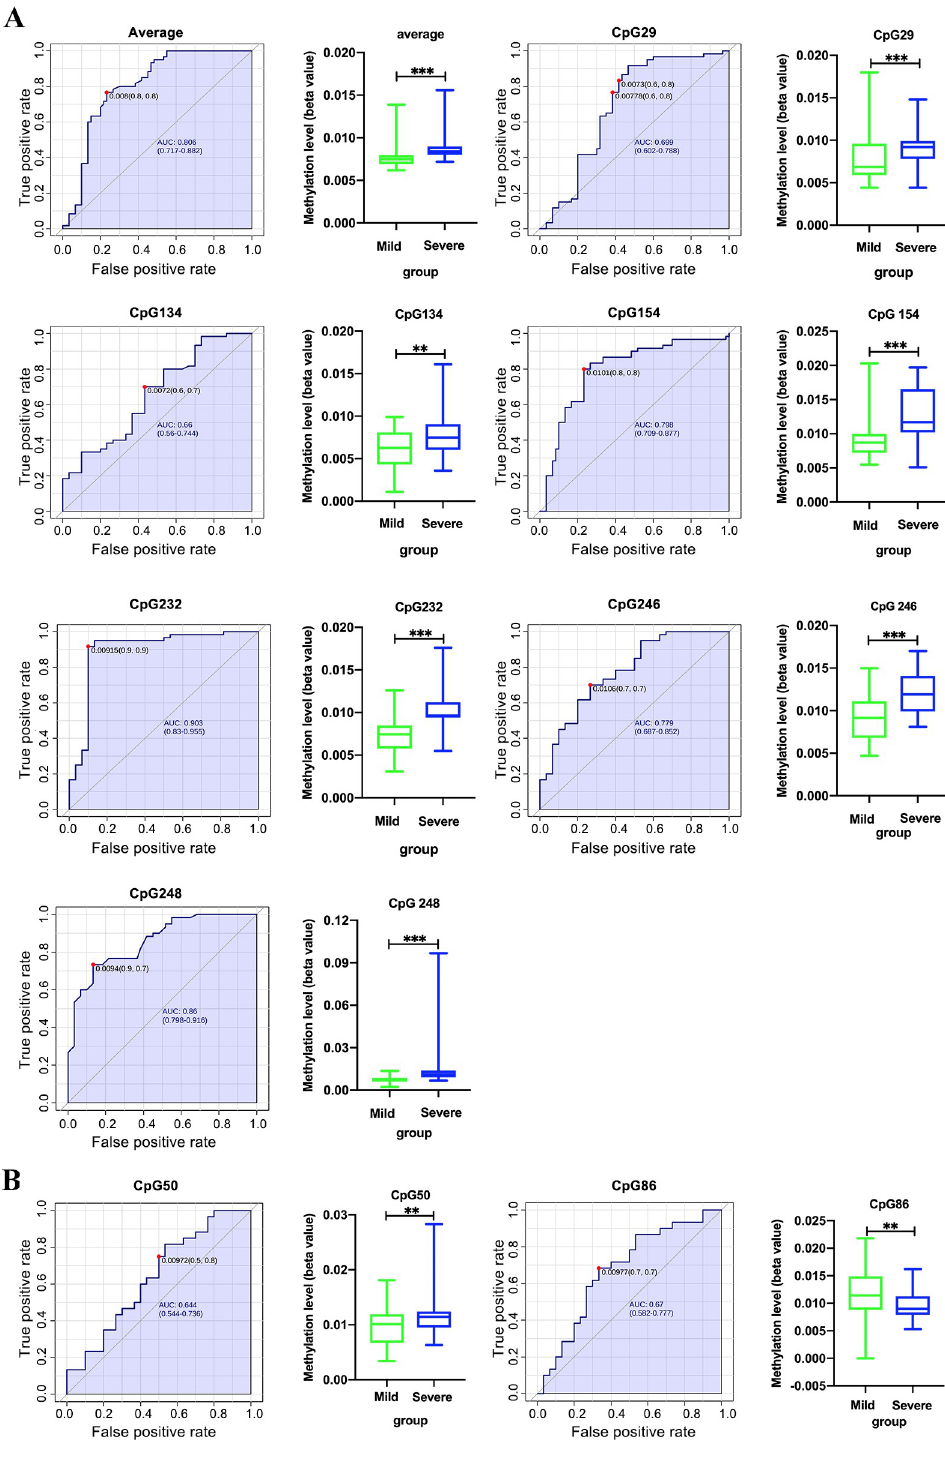
Fig 3. DDX58 methylation status and levels of each positive CpG site (the 29, 134, 154, 232, 246 and 248 CpG sites) between mild and severe EV71-HFMD patients. (A). IFIH1 methylation status and levels of each positive CpG site (the 50 and 86 CpG sites) between mild and severe EV71-HFMD patients. (B) � p < 0.05, �� p < 0.01, ��� p < 0.001.